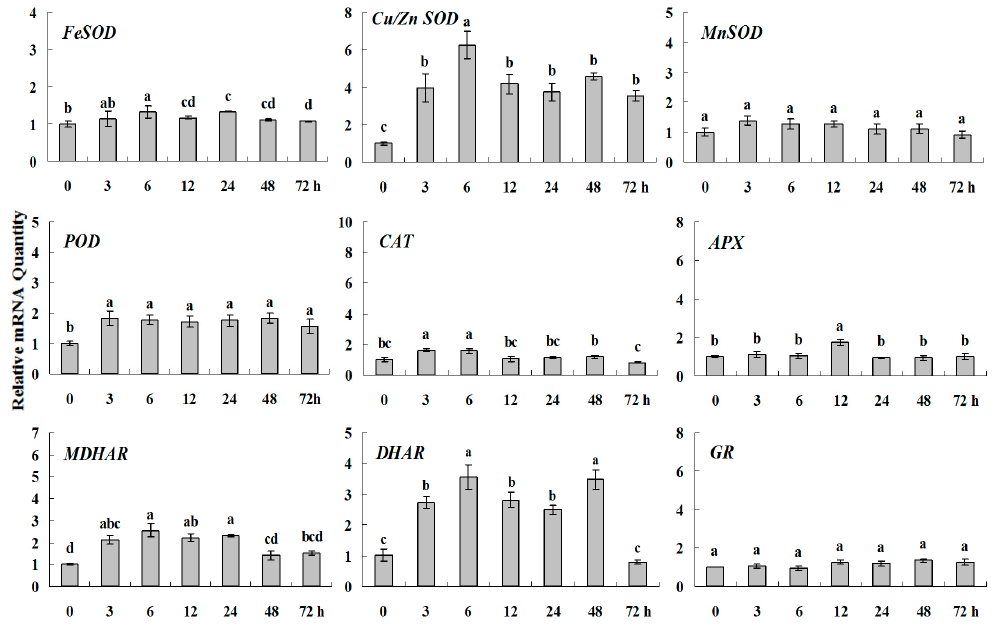
Figure 6. Quantitative real-time RT-PCR was used to analysis of ROS-scavenging enzyme genes expression during heavy metal stress and normalized to β - actin . White clover leaves were sampled after 0, 3, 6, 12, 24, 48 and 72 h treatment. Data represent means of three replicates. Error bars representing standard errors and the different letters above the bars represent significant difference ( p < 0.05).